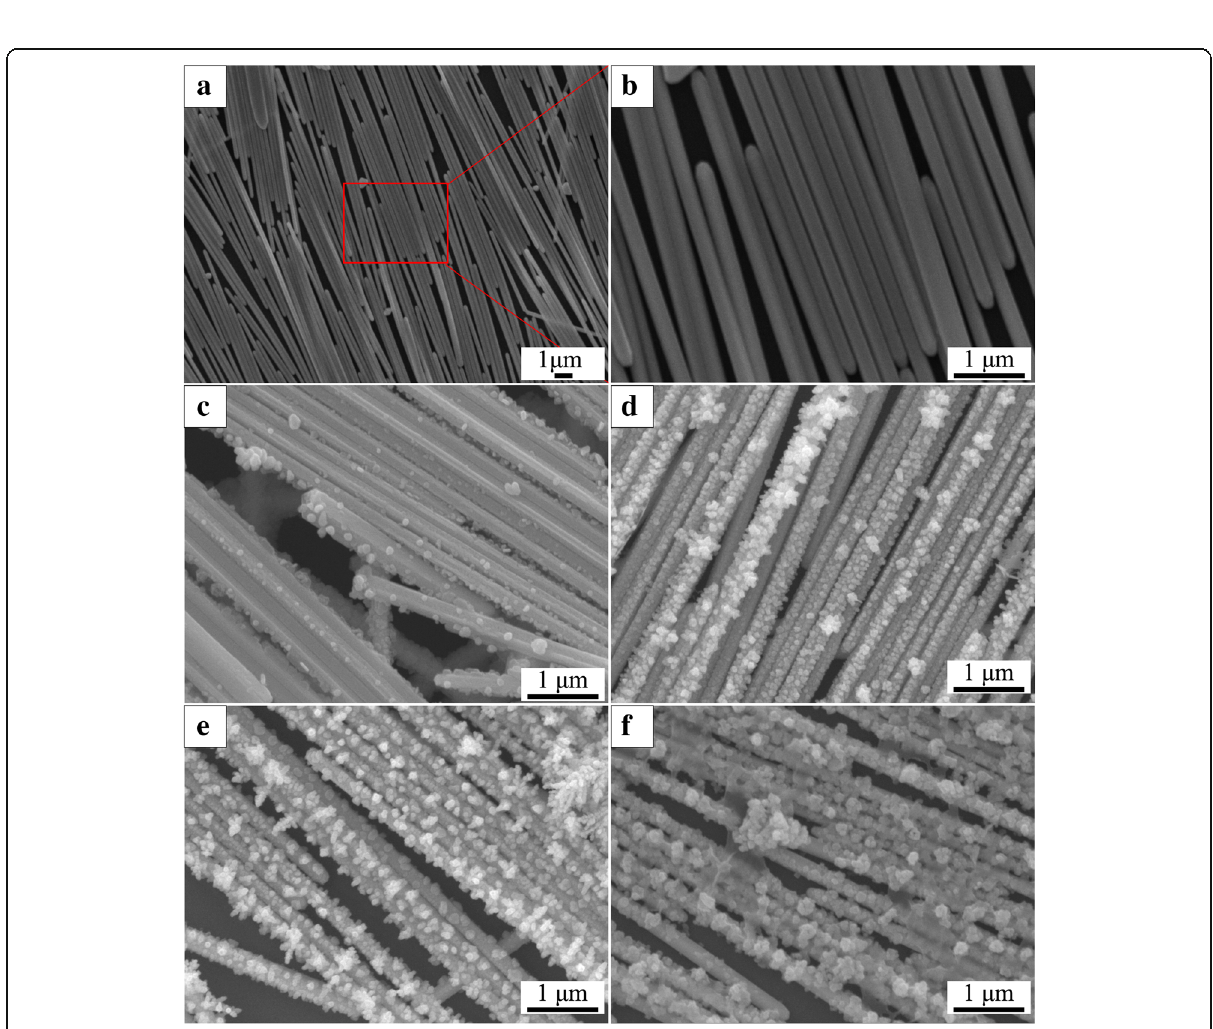
Fig. 2 SEM images of the aligned AgNWs films and different AgNWs@AgNPs films. a , b Different magnifications of SEM images of aligned AgNWs film. c – f Different AgNWs@AgNPs-1, 2, 3, 4 films standing for the deposition time 5 s, 15 s, 30 s, 60 s